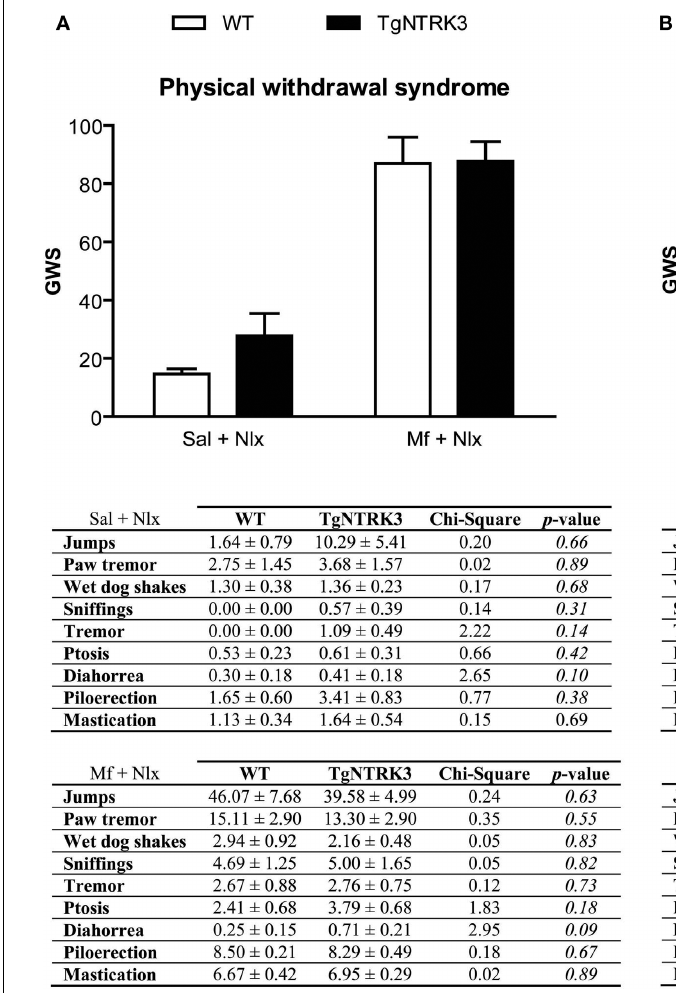
FIGURE 3 | Global withdrawal score after naloxone administration in morphine (Mf)-treated mice. Mice received chronic treatment with (A) increasing or (B) constant doses of morphine. Withdrawal was precipitated in both groups by the administration of the opioid receptor antagonist, naloxone (Nlx, 1 mg/kg, s.c.). Somatic signs of withdrawal were recorded during 45 min,